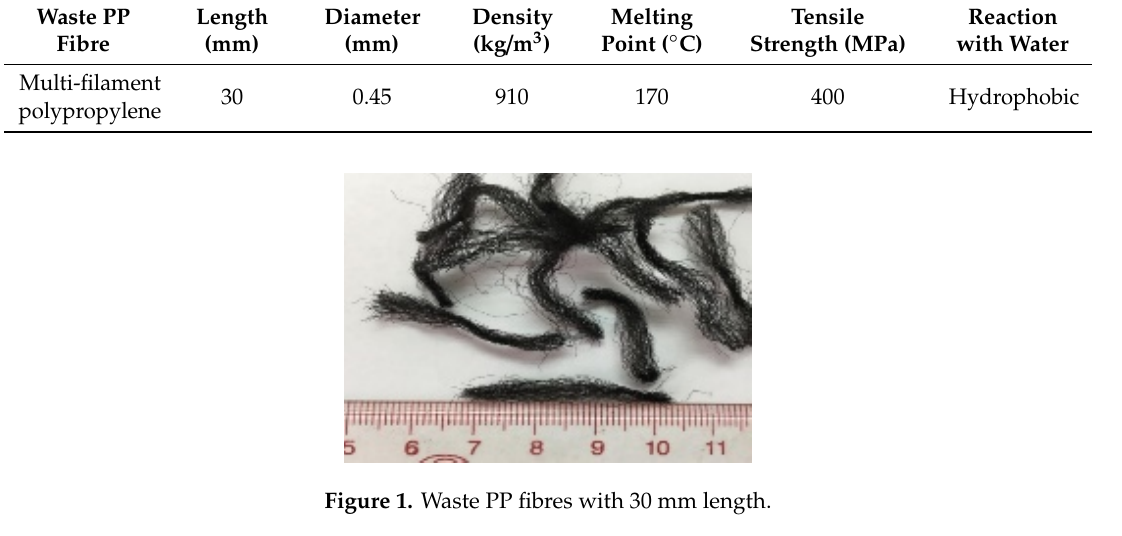
Table 2. Typical properties of fabricated polypropylene (PP) waste fibres.